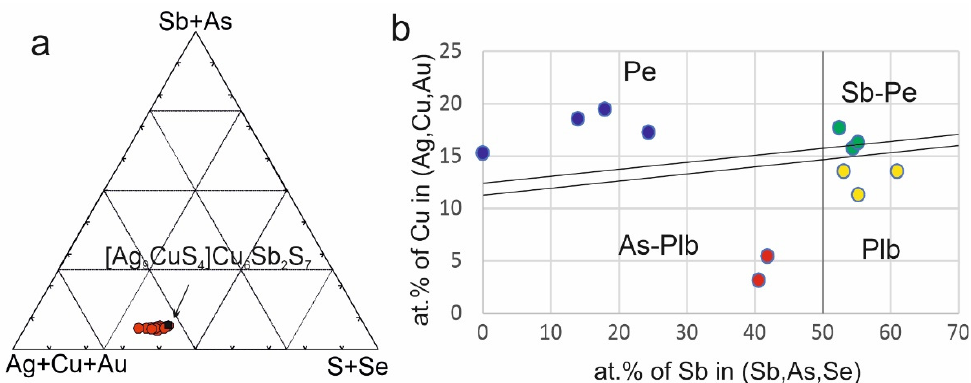
Figure 8. Compositions of the pearceite-polybasite solid solution: ( a ) Compositions obtained in this study (red circles) compared with the idealized empirical formula (black circle); ( b ) relationship between the at.% of Sb in (Sb, As, Se) and the at.% of Ag in (Ag, Cu, Cu), and minerals of the pearceite-polybasite group according nomenclature [18]: Pe—pearceite, Sb-Pe—antimonpearceite, Plb—polybasite, As-Plb—arsenpolybasite.